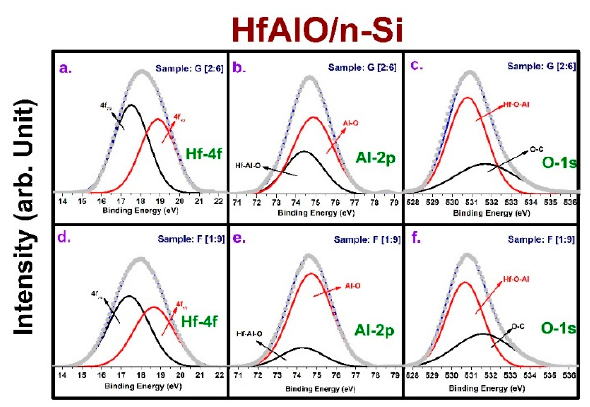
Figure 5. Trap characterization of HfAlO films with different Hf concentrations assumed by atomic- layer-deposition (ALD) cycle ratio: ( a ) interface trap density (D it ) and ( b ) border tap density (N bt ). Inset: frequency dispersion of accumulation capacitance at an applied bias of 2 V.